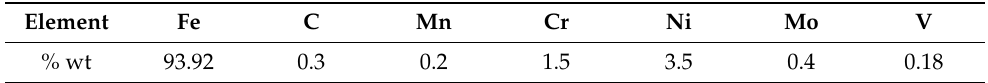
Table 1. Chemical composition of CLARM HBR steel alloy 30NiCrMoV14 [29]. Element